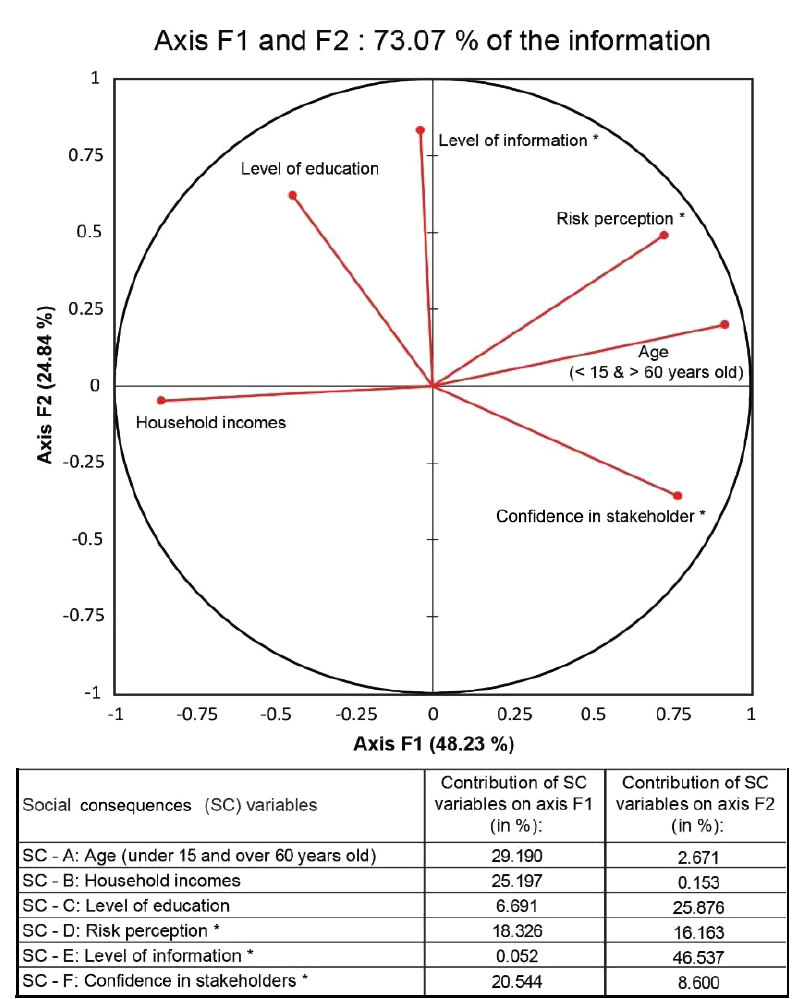
Figure 4. Principal component analysis (PCA) and criteria selected for the SCI